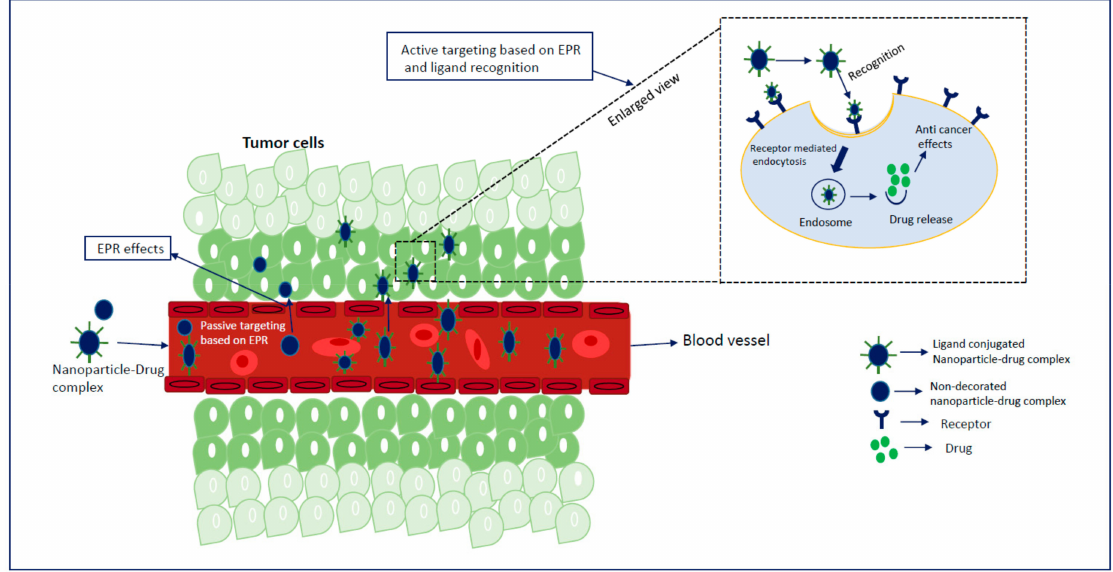
Figure 2. Combination strategy for drug targeting to a solid tumor using nanoparticles (NPs): after entering the systemic circulation, NPs are passively targeted and accumulated in the target tumor site by virtue of the enhanced permeability and retention (EPR) effect. Active targeting is achieved by decorating the surface of NPs with a targeting moiety and by capitalizing the advantages of aberrantly expressed receptors on the surface of tumor cells and EPR effects, resulting in improved drug delivery through receptor-mediated